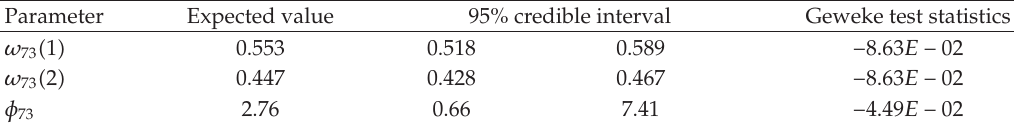
Table 3: Estimation results of mixed ground subsidence